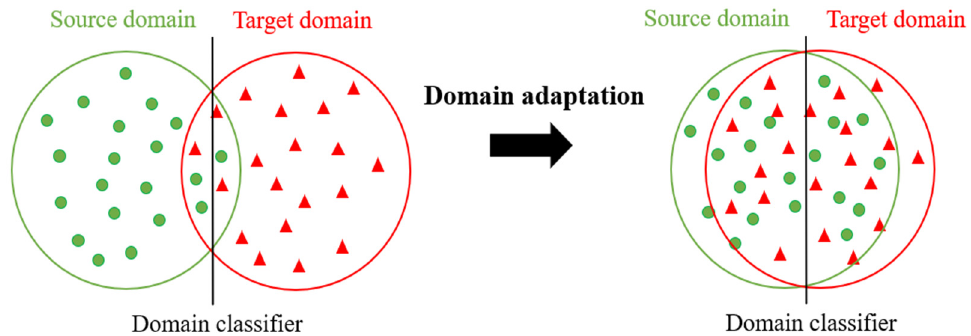
Figure 2. Effect of domain adaptation.